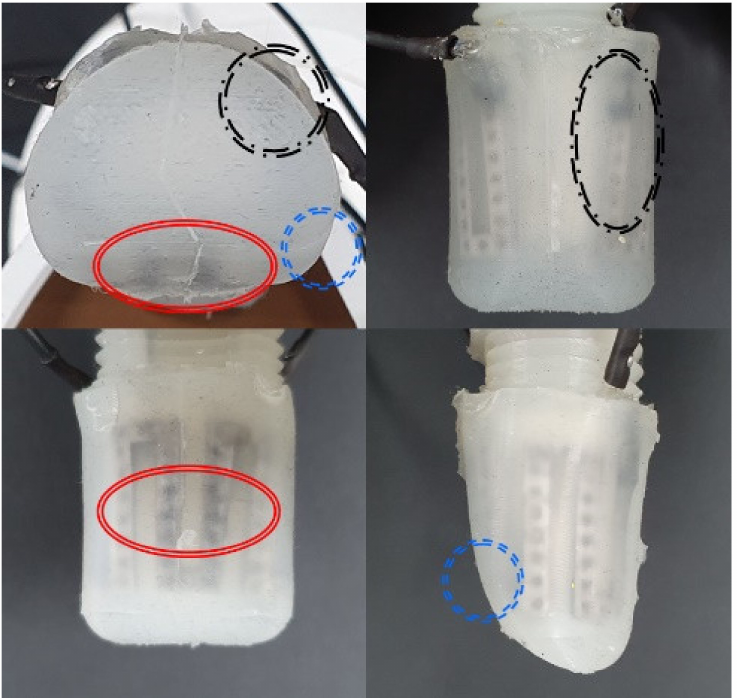
Figure 22. Selectionofareasonthefingerforapplicationofpressure,forposition-basedsensorcharacterization.